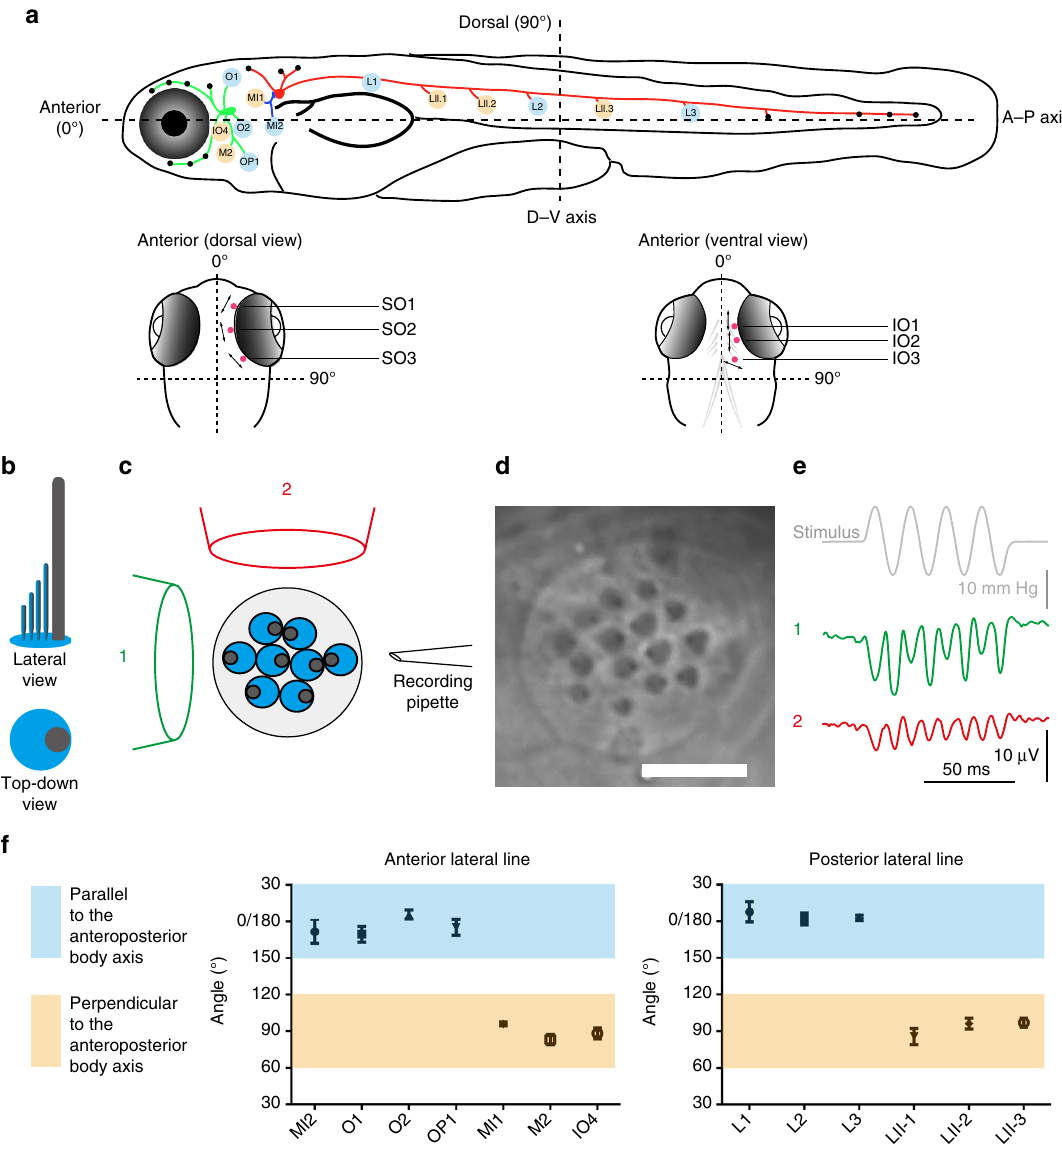
Fig. 1 Axes of best sensitivity for anterior and posterior lateral line neuromasts. a Schematic of the zebra fi sh lateral line at ~6 dpf. (top) Side view. Neuromasts that have been scored are blue or tan and correspond to the graph below. ALL(green), PLL(red), and medial – lateral-line (blue) ganglia contact neuromasts. (bottom) Dorsal and ventral views of the head. Supraorbital (SO) neuromasts 1 to 3 and infraorbital (IO) neuromasts 1 to 3 are marked in red. The mean angle of the orientation of the axis of best sensitivity relative to the A – P body axis of each neuromast is presented as a double-headed arrow. b – e Evaluation of the axis of best sensitivity for a neuromast. b Schematics of hair bundles. Gray and blue protrusions are a kinocilium and stereocilia, respectively. c Experimental con fi guration: a top-down view of a neuromast with a fl uid jet pipette that provides stimuli (1) parallel to the axis along which the bevel-shaped hair bundles face opposite directions or (2) orthogonal to that axis. The pipettes in the diagram are not to scale. d DIC image of hair bundles of a posterior neuromast from which stimulus-evoked microphonic potentials were recorded. Scale bar = 5 μ m. e Recordings from an A – P oriented L3 neuromast with fl uid jet pipettes stimulating, serially, from two different directions depicted in c . f Graphs of mean angle of the orientation of the axis of best sensitivity relative to the A – P body axis of each anterior and posterior neuromast position ± SEM ( n = 4 – 7). Each axis with a range from 60° to 120° from the A – P body axis is de fi ned perpendicular (tan). Each axis with a range from 0° to 30° or 150° to 180° from the A – P body axis is de fi ned as parallel (blue). ALL nomenclature: opercular (OP), mandibular (M), infraorbital (IO), supraorbital (SO), middle (MI) and otic (O). PLL nomenclature: L neuromasts are A – P oriented; LII neuromasts are D – V oriented. These different neuromast types are derived from different migrating primordia during